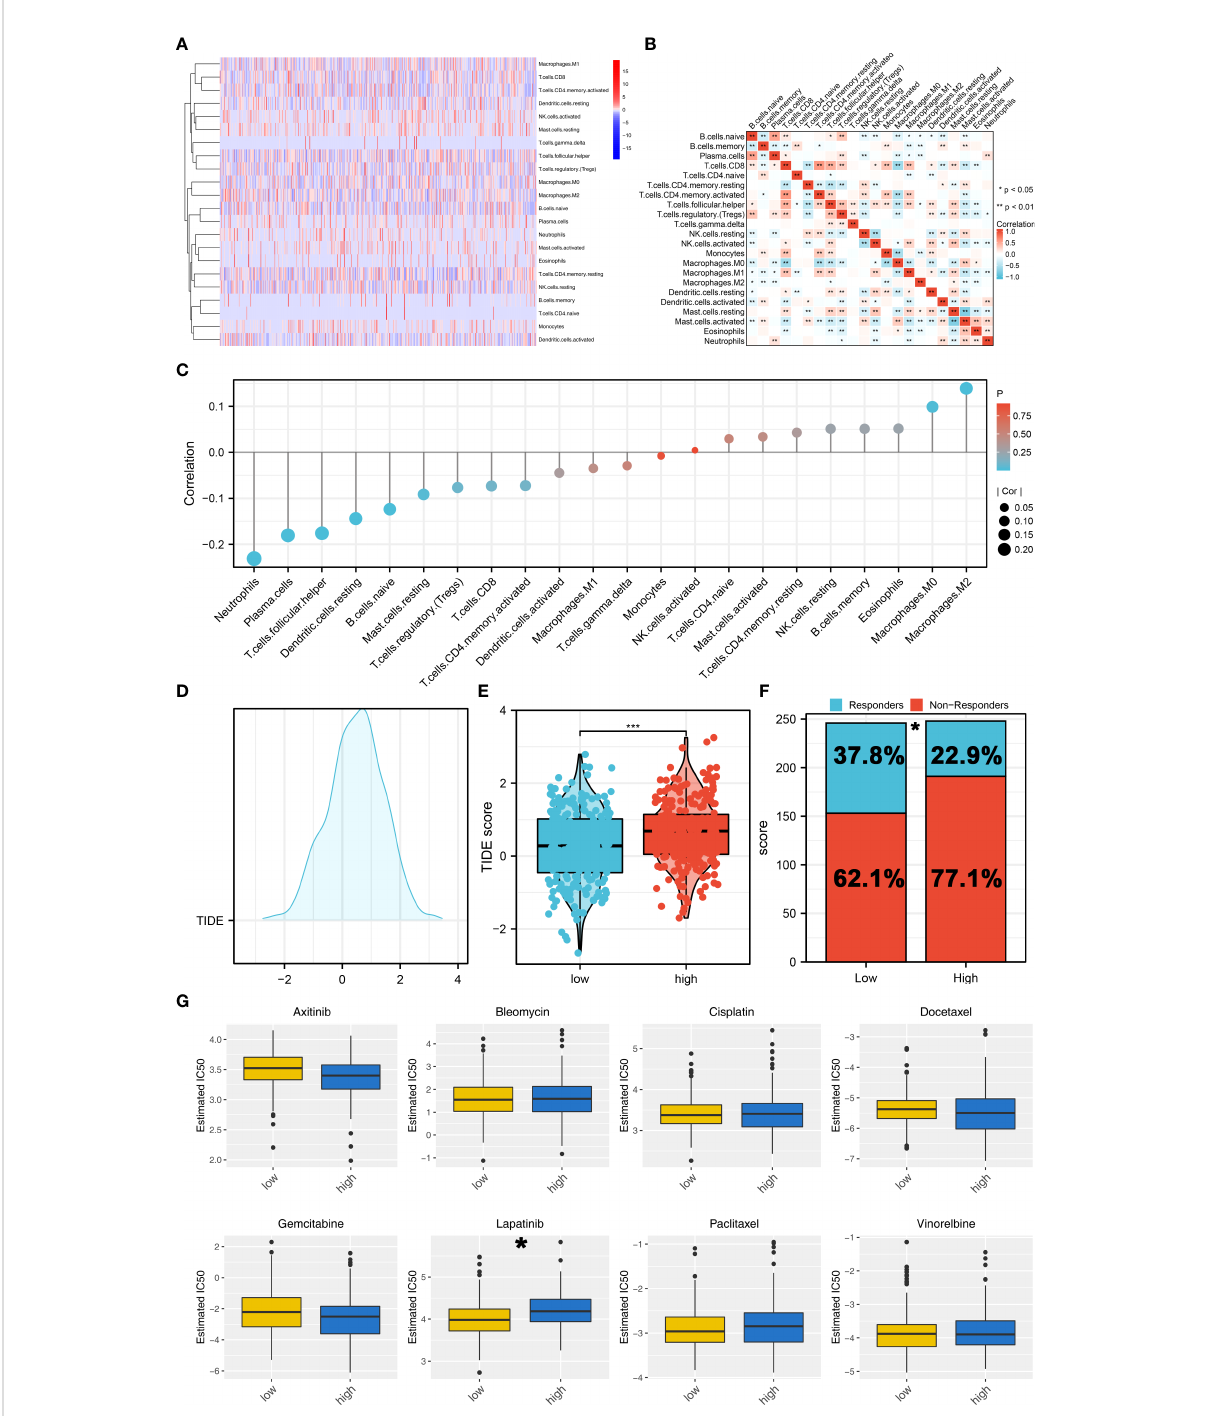
FIGURE 7 Immune related analysis. (A) CIBERSORT algorithm was used to quantify the 21 immune cells in tumor microenvironment; (B) The co- expression analysis of these immune cells; (C) The correlation of the riskscore and immune cells; (D) TIDE analysis was performed to assess the sensibility of immunotherapy; (E) The low-risk patients might have a lower TIDE score; (F) A higher percentage of immunotherapy responders was observed in low-risk patients; (G) Drug sensitivity analysis between high and low risk groups. *P < 0.05; *** P <